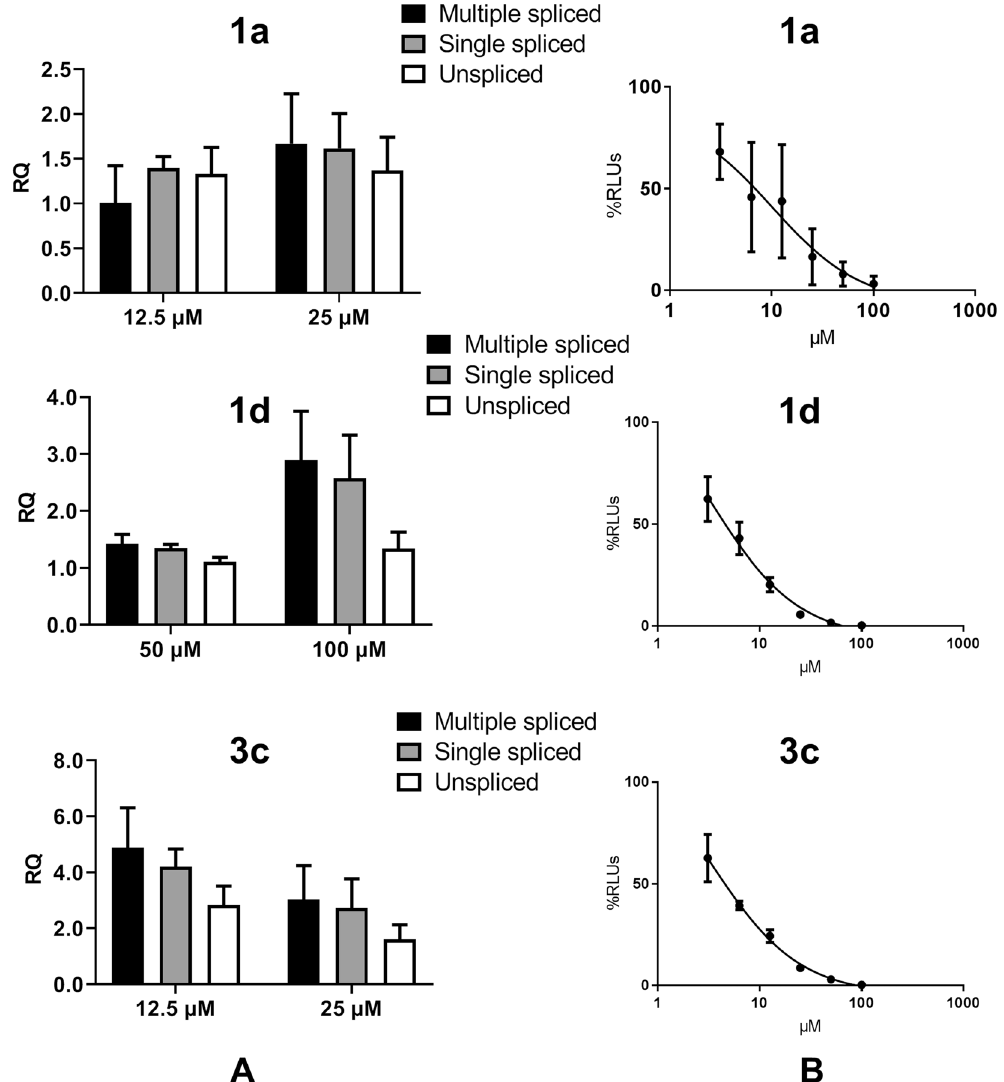
Figure 6. Effect of terphenyls 1a , 1d and 3c on HIV-1 RNA splicing and LTR-dependent gene expression. ( A ) Relative quantities (RQ) of unspliced, single-spliced and multiple-spliced HIV-1 RNA transcripts in cells treated with two concentrations of 1a , 1d or 3c . The image shows transcript quantities measured at 48 hours after infection, using transcript levels obtained from untreated cells as a reference (RQ = 1). ( B ) Inhibition of HIV-1 LTR-dependent gene expression as a function of terphenyl concentration. The results are expressed as a percentage of relative luminescence units (RLUs), where 100% is the luminescence level obtained in the presence of the vehicle used to dissolve the